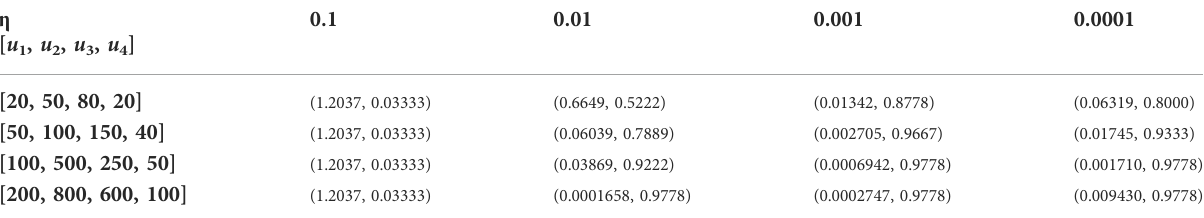
TABLE 3 ( Loss , Accuracy ) for varying number of hidden neurons ( u = [ u 1 , u 2 , u 3 , u 4 ]) and learning rate ( η ).